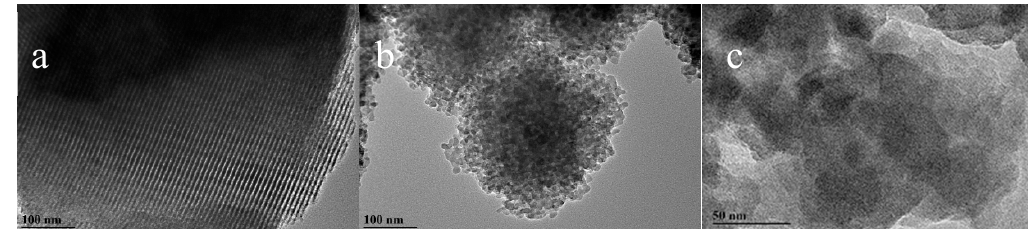
Figure 2. images of ( a ) MCSI-0.4 calcined at 1023 K in N 2 ; ( b , c ) HPZ-CSI-8h calcined at 823 K in O 2 .